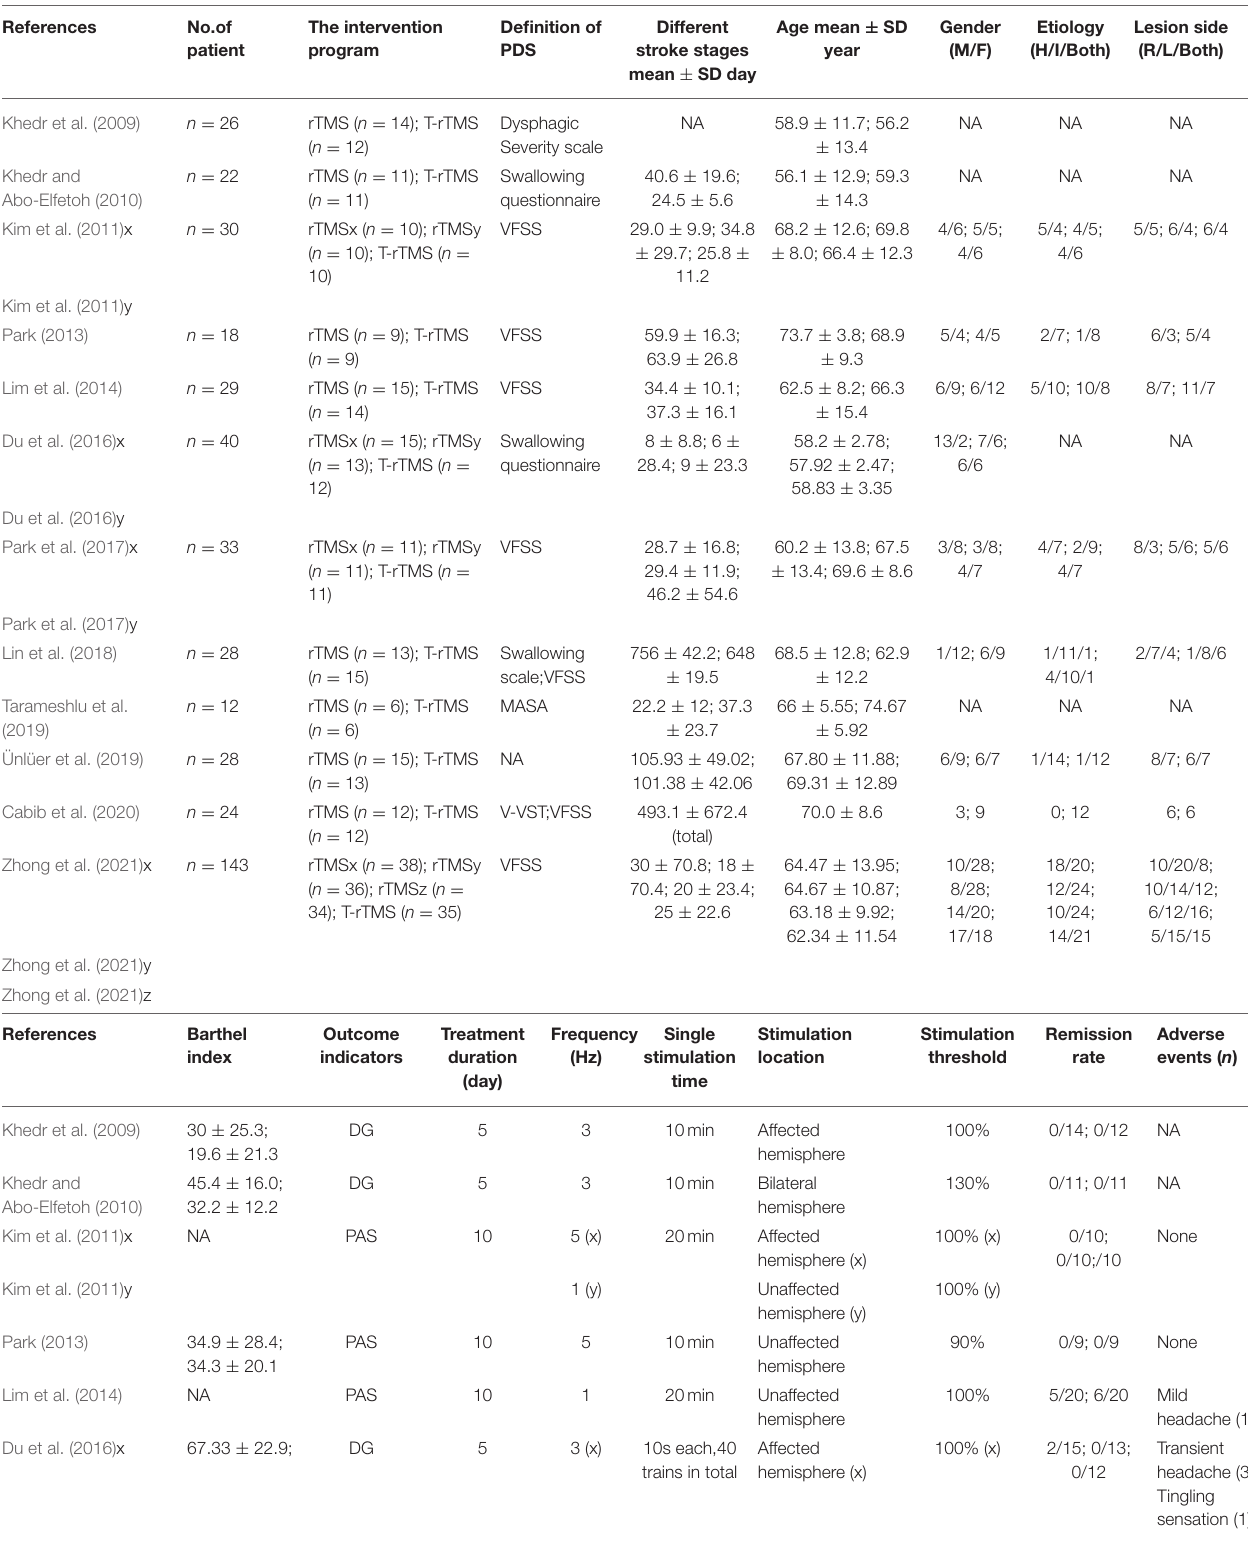
TABLE 1 | Characteristics of included